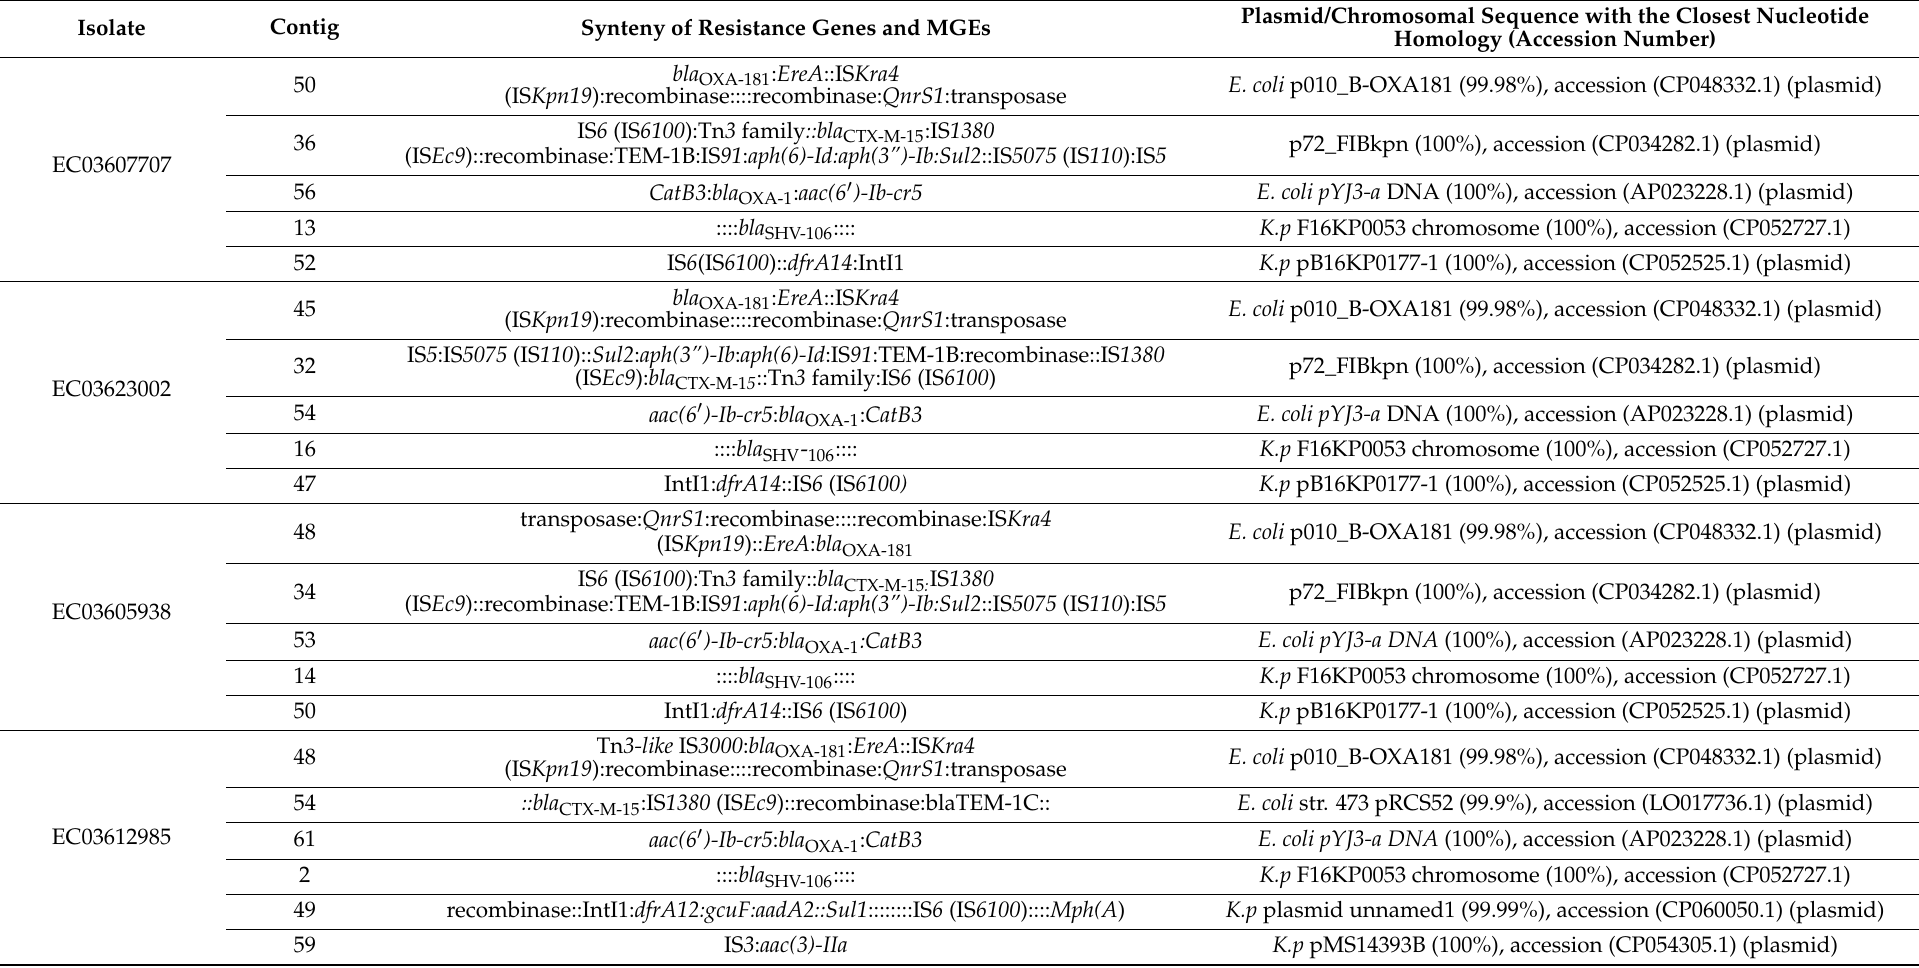
Plasmid/Chromosomal Sequence with the Closest Nucleotide